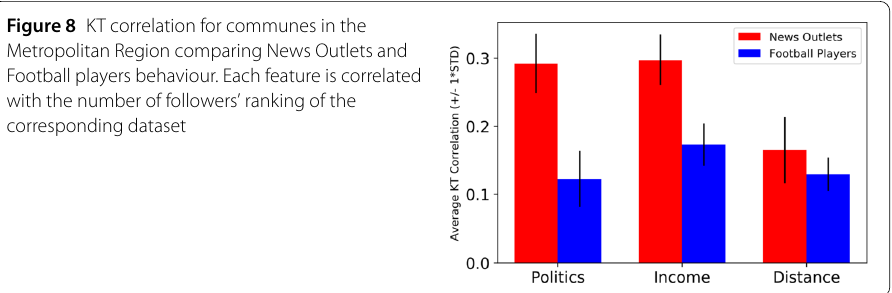
Figure 8 KT correlation for communes in the Metropolitan Region comparing News Outlets and Football players behaviour. Each feature is correlated with the number of followers’ ranking of the corresponding